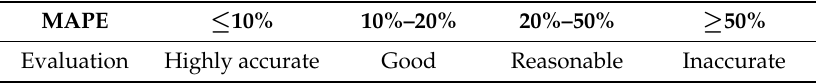
Table 1. Benchmark for modeling accuracy evaluation.